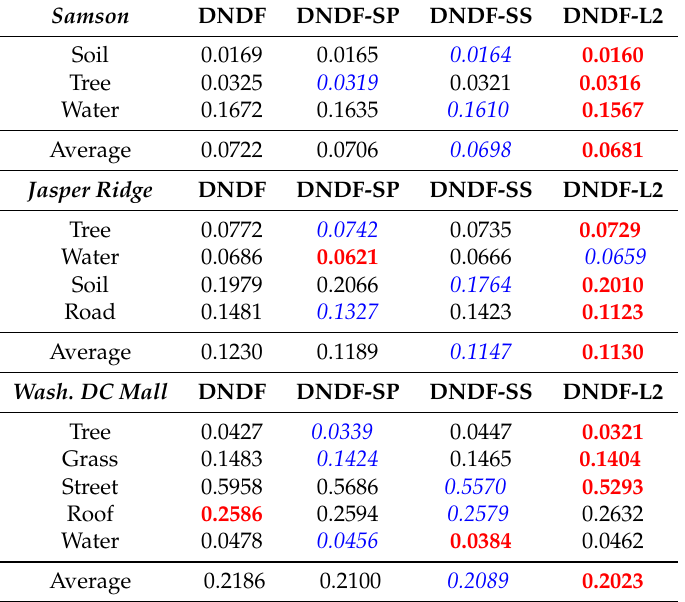
Table 3. Performance comparison w.r.t the SAD values on three datasets (in radians), where DNDF denotes the proposed method without any regularization, DNDF-SP, DNDF-SS, and DNDF-L2 represent the proposed method with sparse regularization, self- supervised regularization and both regularizations, respectively. Red bold and blue italic denote the best and second-best results, respectively.